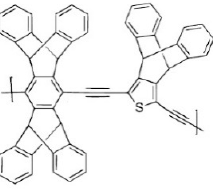
Figure 14. Structural diagram of poly(aryleneethynylene). Reproduced from Reference [84].